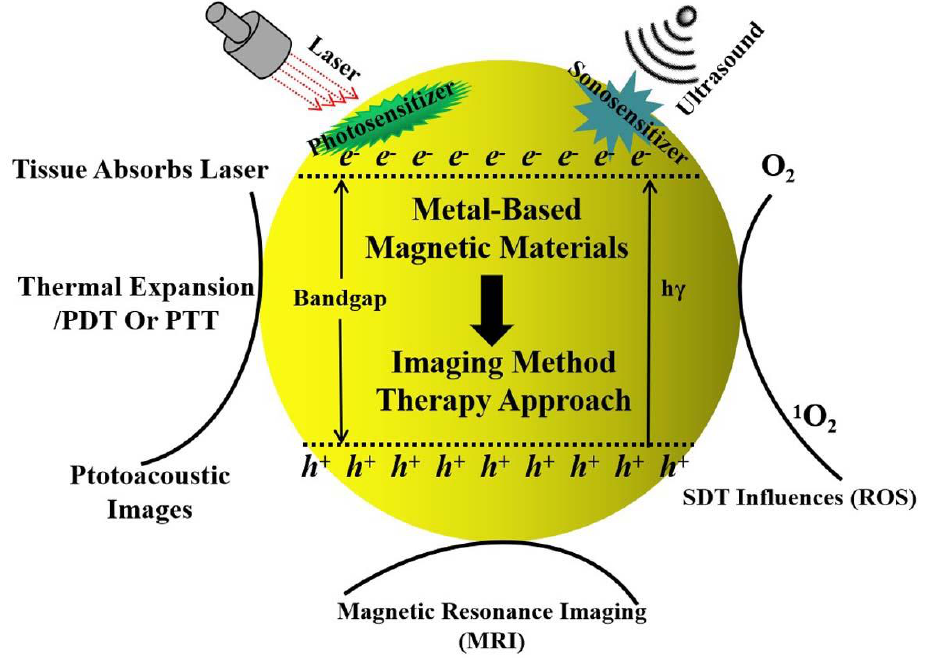
Figure 1. Scheme of metal-based magnetic materials occurring through different further applications due to mechanisms formed in real treatment.